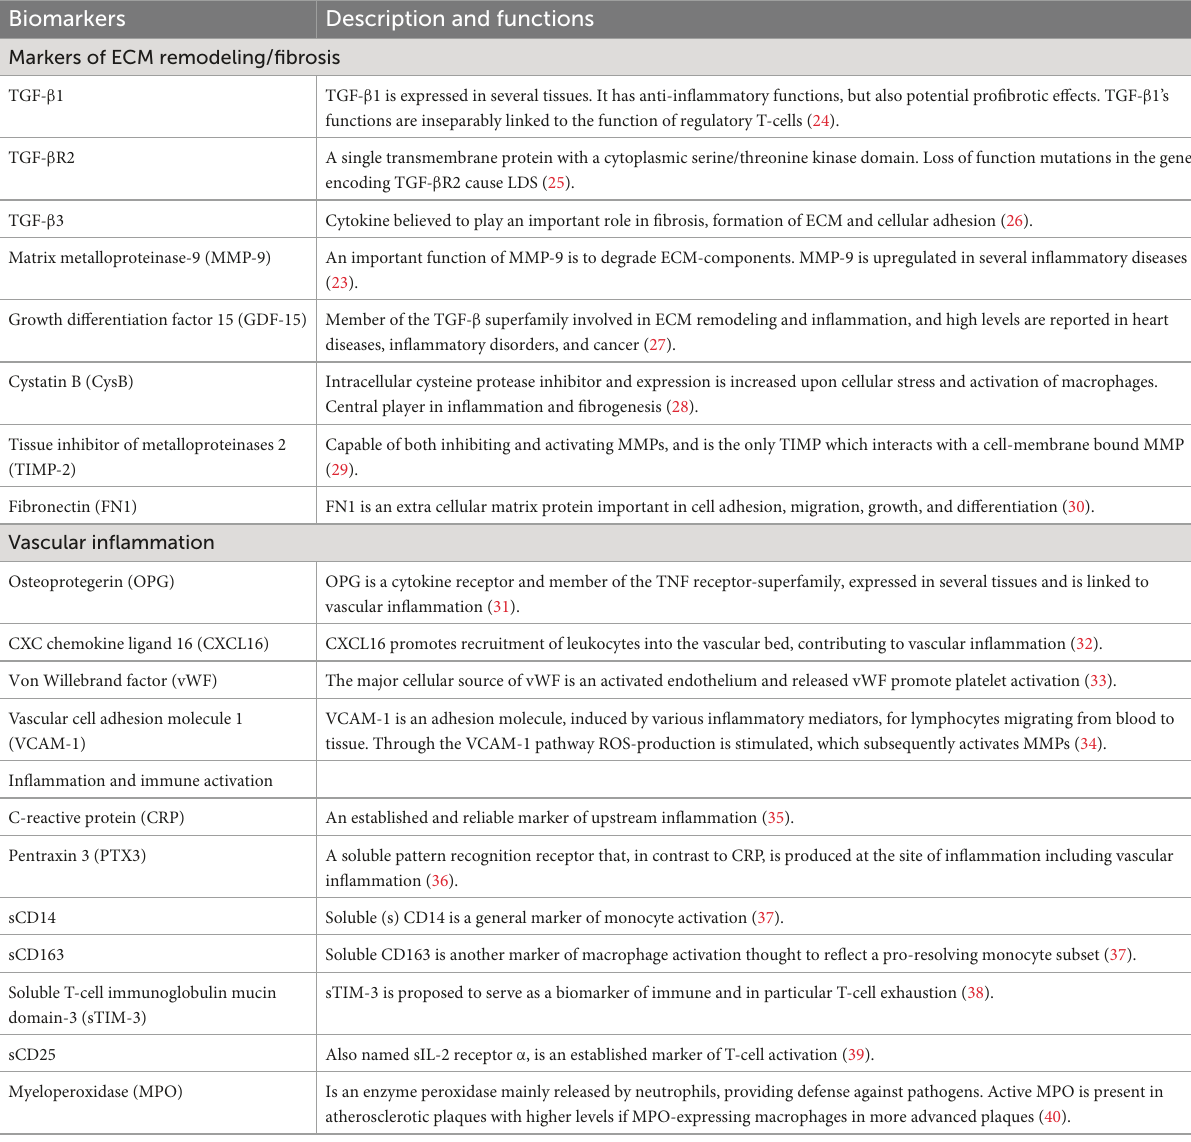
TABLE 2 Markers of extracellular matrix remodeling, vascular inflammation, and immune activation.